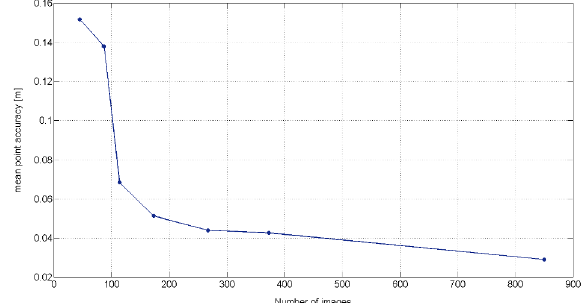
Figure 11: Adjustable camera angle, low airspeed and high image overlap using a multi-rotor UAV for image acquisition enables optimal